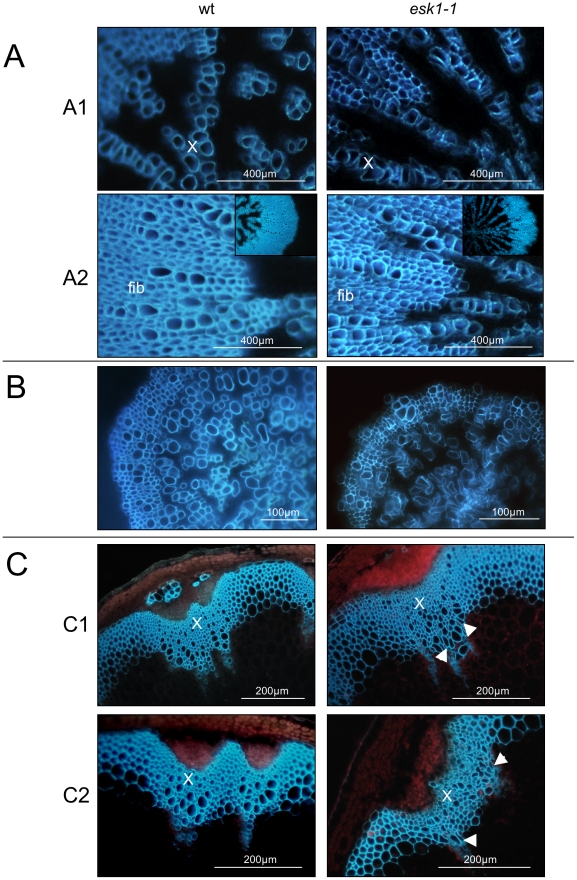
Comparison of vascular tissue of esk1-1 and wild type, in hypocotyls, roots and stems.Vascular tissue is shown for esk1-1 on the left hand side and for wild type (wt) on the right hand side. A. Transverse section of hypocotyl observed under UV light. A1, fibers (fib); A2, xylem cells (X). B. Transverse section of root observed under UV light. C. Transverse section of the stem base (C1) and at mid-height (C2) observed under UV light. Arrowheads indicate collapsed xylem.